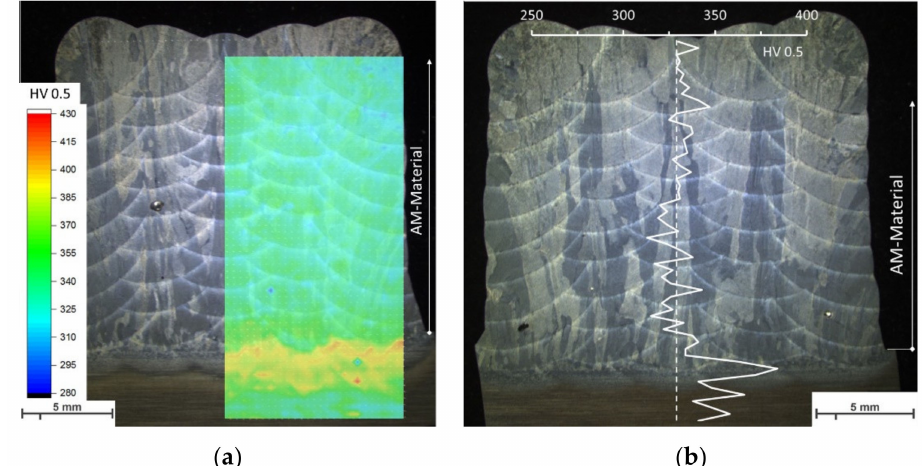
Figure 12. ( a ) Hardness-mapping of transverse cross-section in as-deposited condition and ( b ) hardness line scan in PWHT condition (standard deviation = ± 9